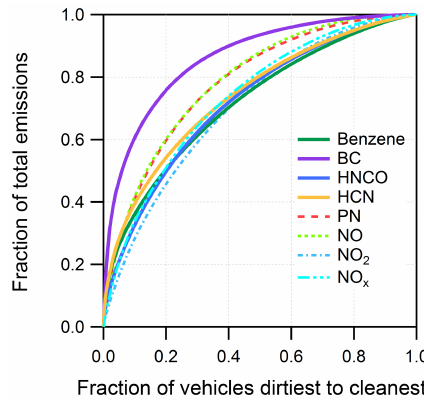
Figure 5. Cumulative emission factor distributions for SPP plume- based measurements: benzene (solid, green), BC (solid, purple), HNCO (solid, blue), HCN (solid, yellow), NO (dotted, light green), NO 2 (dotted, light blue), NO x (dotted, light teal), and particle num- ber (dotted, pink). A one-to-one line would indicate that all vehicles have the same emission